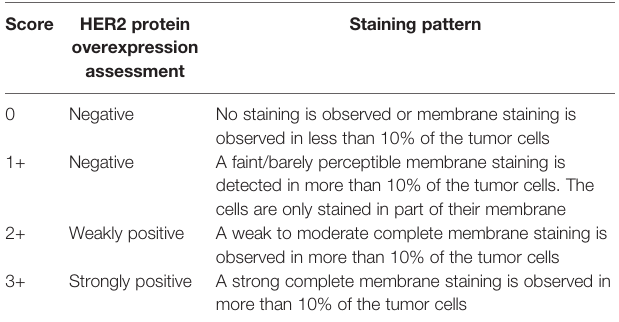
TABLE 1 | The FDA approved scoring criteria for HercepTest ™ in breast cancer (17). Score Staining